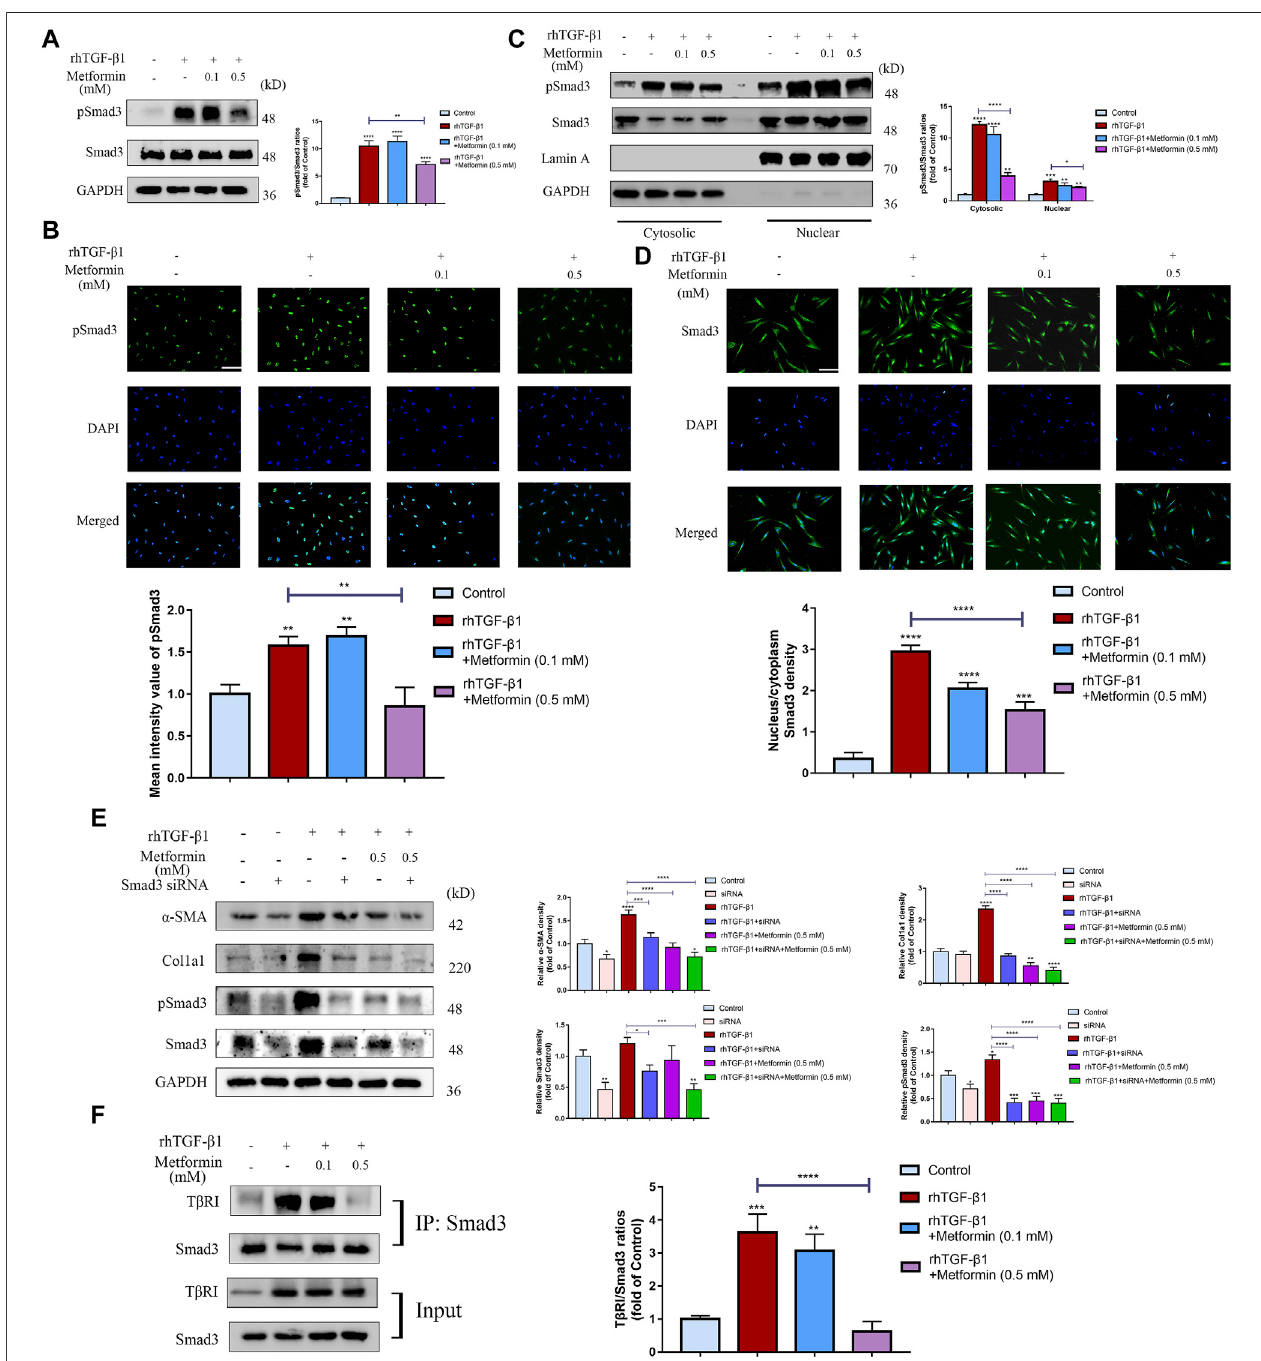
FIGURE6| Metformin blocks TGF- β 1/Smad3 signaling in cultured human colonic fi broblasts. (A) Representative western blot graphs of pSmad3 indicate that metformin inhibits TGF- β 1-induced Smad3 phosphorylation in CCD-18Co cells. Relative densitometric ratios of pSmad3 to Smad3 are shown. (B) CCD-18Co cells induced by TGF- β 1 were immunocytochemically stained with primary pSmad3 antibody. Representative ICC staining images are shown. And mean intensity quantitation of pSmad3 in CCD-18Co cells was performed. (C) Western blots analyses show that metformin suppresses the increase of pSmad3 in the cytoplasm and nuclear stimulated by TGF- β 1. Subcellular nuclear and cytosolic fractions were analyzed by western blot for pSmad3 and Smad3. The blots were analyzed with antibodies against Lamin A or GAPDH to con fi rm identical protein loadings to further assess the relative content of the nuclear and cytosolic fractions ( n = 3 independent experiments). Relative densitometry values of pSmad3 are shown besides the blots as ratios relative to Smad3. (D) Representative Immuno fl uorescence graphs show that metformin suppresses nuclear translocation of Smad3 stimulated by TGF- β 1. Green signals represent the Smad3 protein. And blue fl uorescence signals represent the nucleus. Intensity nucleus/cytoplasm ratios of Smad3 was performed. (E) After being infected with scrambled or